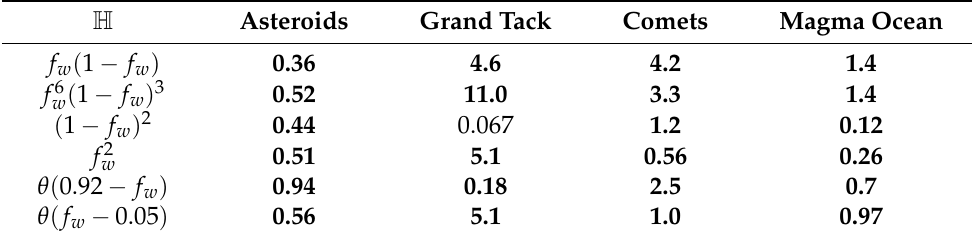
Table 1. Bayes factors for various combinations of water delivery mechanisms and habitability conditions. All values are the product of the probabilities of observing the five values of the constants we vary, relative to the baseline case where habitability is independent of water content. Values above 0.1 are displayed in bold. All values are computed assuming the yellow + entropy + terr + temp + C/O condition.